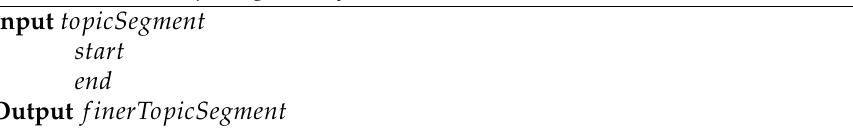
Algorithm A4 makeTopicSegmentByIndex .